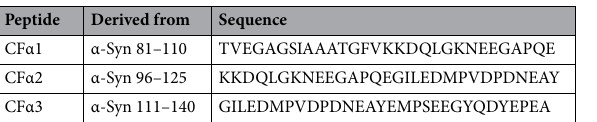
Figure 5. Reversal of α-Syn oligomer inhibition of fusion using small peptide fragments of α-Syn. ( A ) Thirty- residue peptides derived from the C-terminal domain of α-Syn, which bind to Syb2, competitively with α-Syn oligomers: CFα1 (a.a. 81–110), CFα2 (a.a. 96–125), and CFα3 (a.a. 111–140). This figure was created by Adobe illustrator CS6 (Adobe). ( B ) Small peptide-induced reversal of fusion inhibition by α-Syn oligomers. The dotted line indicates the extent of lipid mixing with α-Syn oligomers (10 nM). CFα1 and CFα2 increased vesicle fusion in the presence of α-Syn oligomers (10 nM). CFα3 had no effect on fusion inhibition by α-Syn oligomers (± SEM, N = 3). *P < 0.05, **P < 0.01, ***P < 0.001 by Student’s t test. ( C ) The effect of small peptides on vesicle fusion in the absence of α-Syn oligomers. CFα peptides (250 nM) showed a negligible effect on vesicle fusion, while 500 nM CFα peptides slightly reduced vesicle fusion (± SEM, N = 3). ( D ) Test of peptide binding to the lipid membranes. Protein-free vesicles (20 μM, F ) were added to a 20 μM T-V mixture in the presence of small peptides (500 nM) and α-Syn oligomers (10 nM). The addition of the protein-free vesicles showed no effect on the reversal effect of the small peptides (± SEM, N = 3). All graphs shown were produced using OriginLab 8.5 software (OriginLab Corporation) and edited by Adobe Illustrator CS6 (Adobe). Peptide Derived